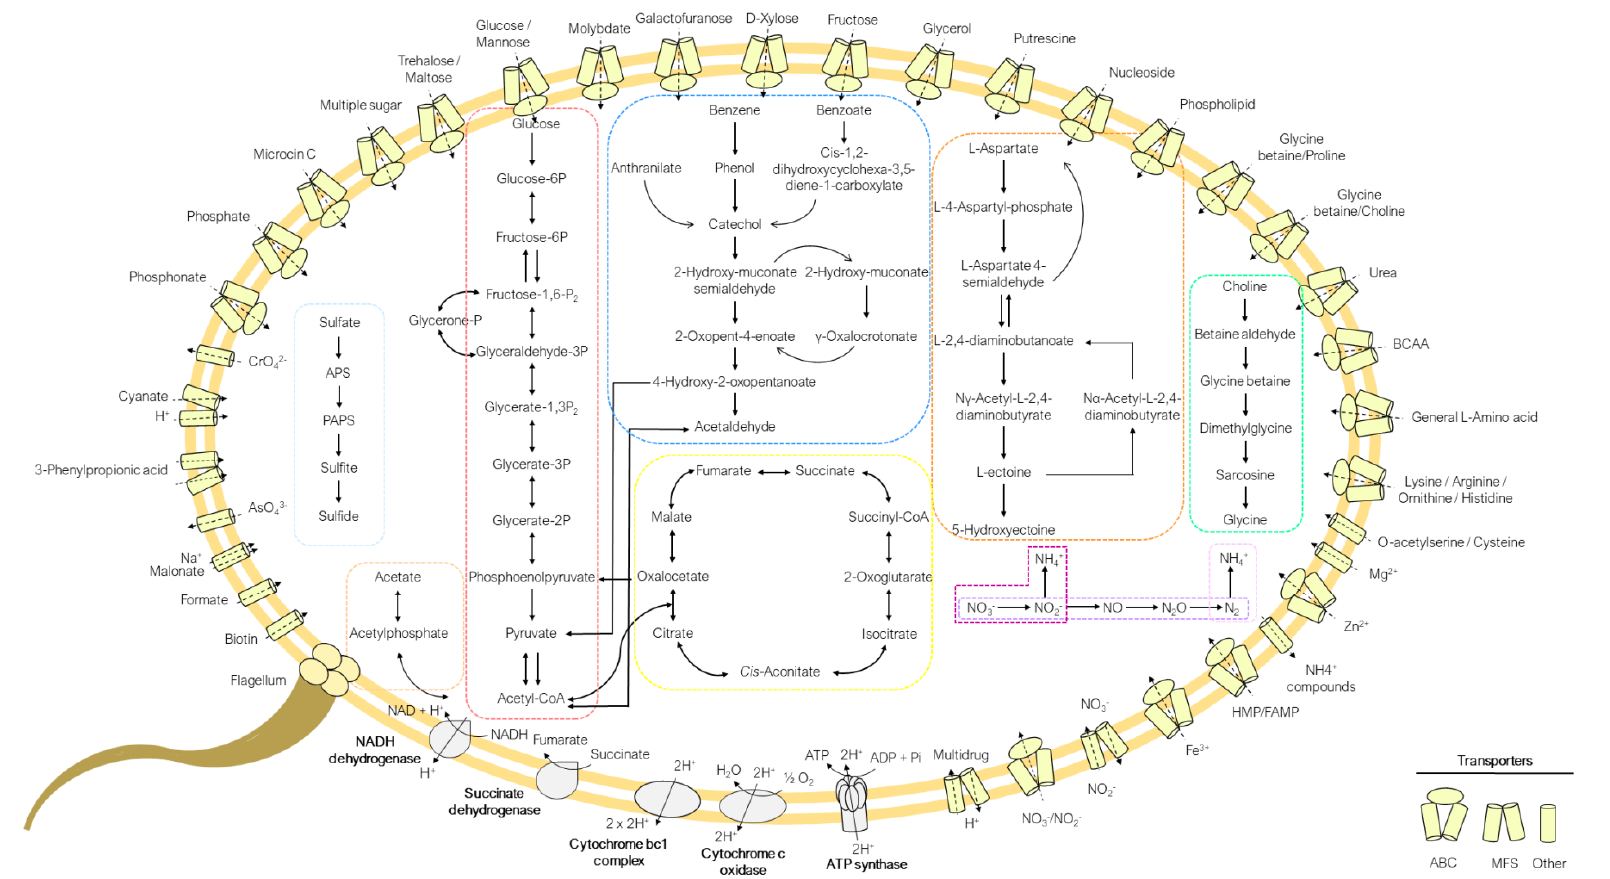
Figure 5. Metabolic reconstruction of strain D7 T . Pathways included in color boxes from left to right: assimilatory sulfate reduction, acetate pathway, glycolysis, aromatic hydrocarbons’ degradation pathways, tricarboxilic acid cycle (TCA), ectoine biosynthesis and degradation pathways, nitrogen metabolism (dissimilatory nitrate reduction, denitrification and nitrogen fixation pathways), and glycine betaine biosynthesis and degradation pathways.